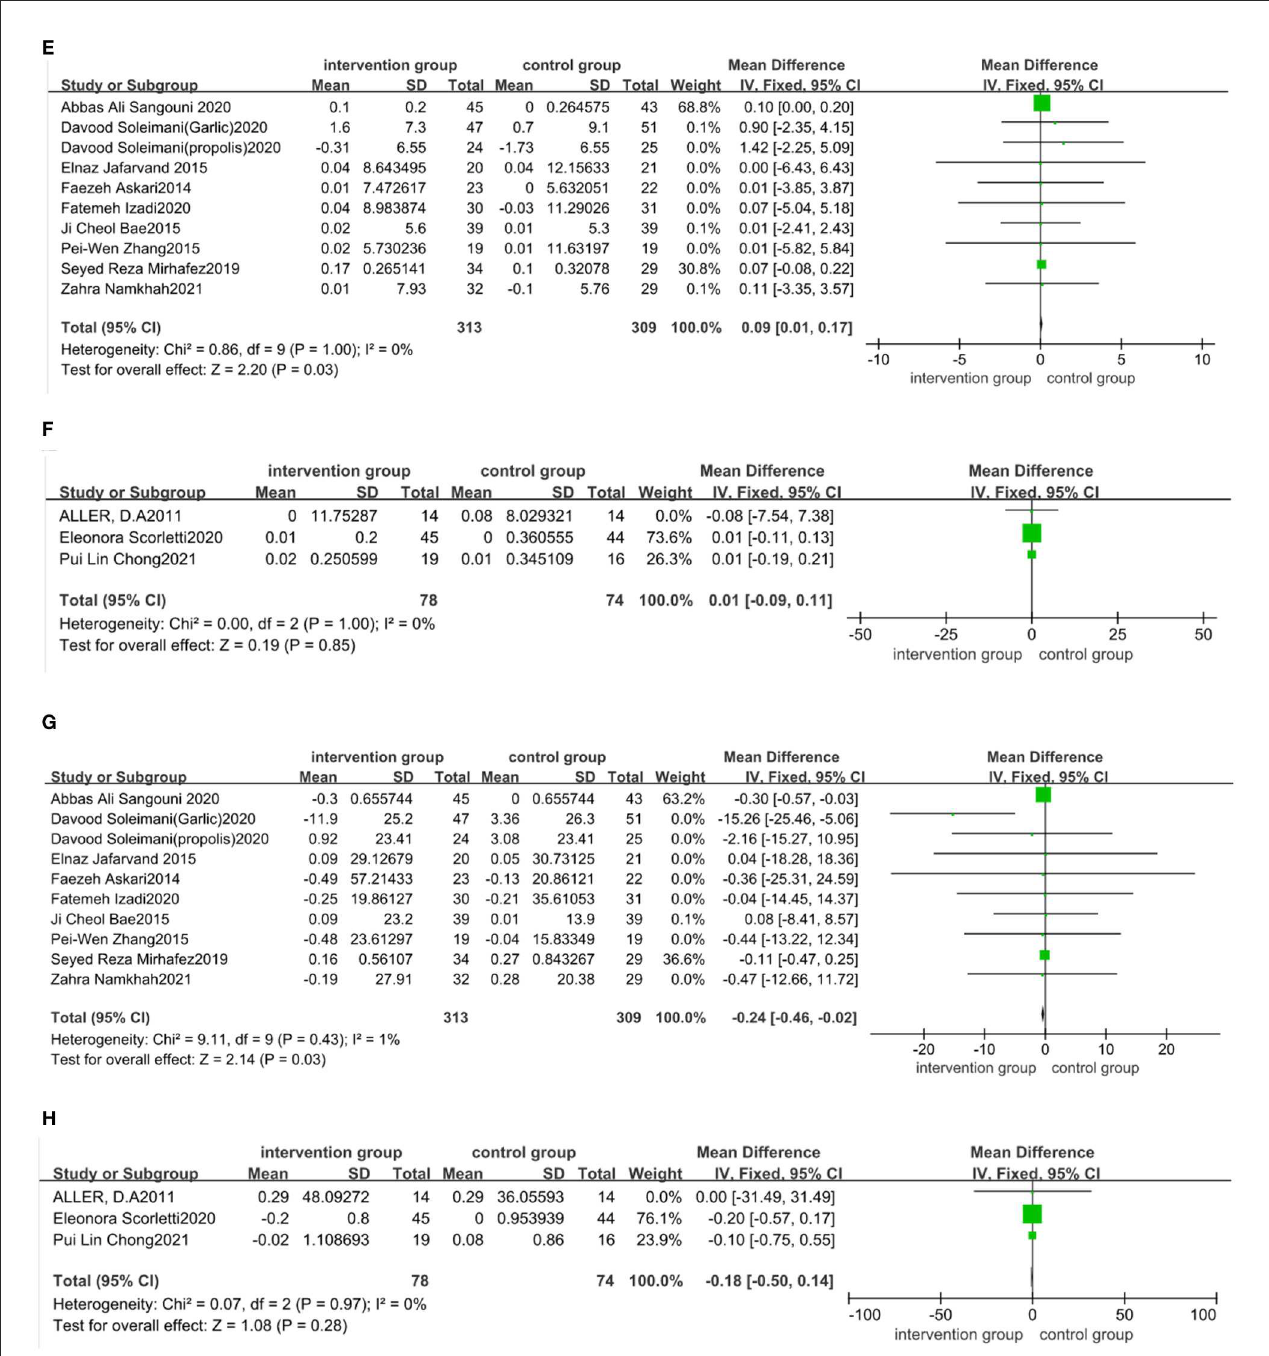
FIGURE6 Forest plot of the effect of functional foods and dietary supplements on lipid profiles (effect of A : antioxidants on TG; B : probiotic/ symbiotic/prebiotic on TG; C : antioxidants on TC; D : probiotic/symbiotic/prebiotic on TC; E : antioxidants on HDL-C; F : probiotics/symbiotic/prebiotic on HDL-C; G : antioxidants on LDL-C; and H : probiotic/symbiotic/prebiotic on LDL-C).